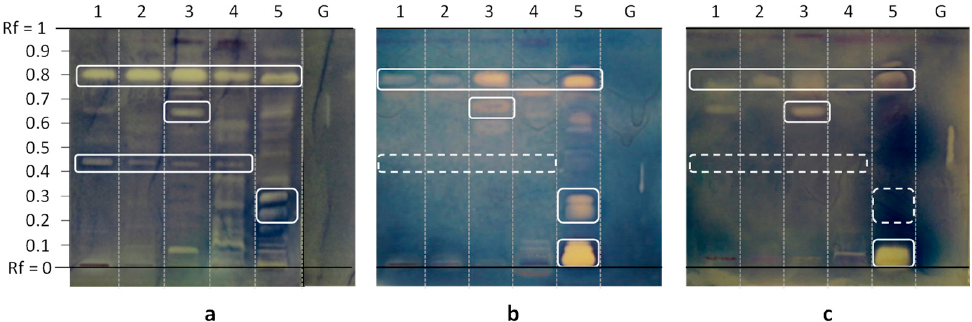
Figure 2. TLC bioautograms obtained with EtOAc extracts from 1: Neoboletus erythropus #1; 2: Peziza vesiculosa ; 3: Scleroderma citrinum #2; 4: Amanita muscaria ; 5: Fomitopsis pinicola ; G: gentamicin, against ( a ) E. faecalis ; ( b ) S. aureus ; ( c ) S. epidermidis . The overall number of inhibition zones is reported in Table 2, and details of inhibition zones with corresponding retention factors (Rf) values can be found in Tables